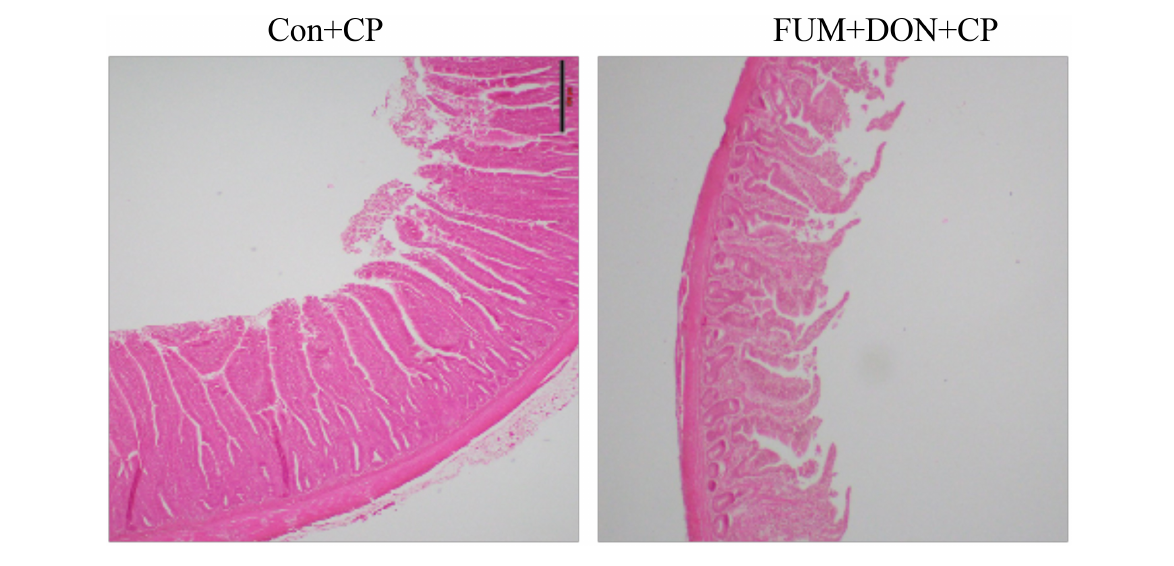
FIGURE2 Effect of subclinical fumonisins (FUM) and deoxynivalenol (DON) contamination on Ileum histomorphology at d 21. Broilers were fed control or mycotoxin (FUM 3 mg/kg diet + DON 4 mg/kg diet). All birds received 1 × 10 8 CFU/bird of C. perfringens on d 19 and 20 ( n = 8). Haematoxylin and eosin staining; Scale bar = 500 µ